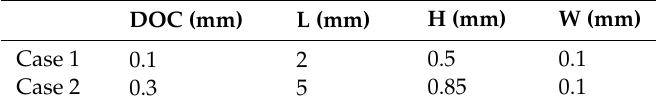
Table 1. The model dimensions and depths of cut (DOC) used.